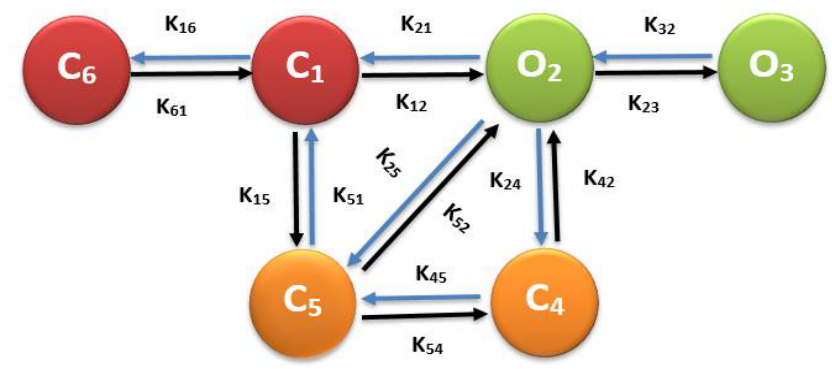
Figure 2. Schematic diagram of the six-state Markov model of the L-type Ca 2+ channel. During resting potential, all L-type channels are in a closed state (C 1 , and a change in the membrane potential activate them into an open state (O 2 ). A channel in O 2 state may continue to an open state (O 3 ) or transition into the voltage-dependent inactivated state (C 5 ), or excess Ca 2+ in dyadic subspace may bring them into the Ca 2+ -dependent inactivated state (C 4